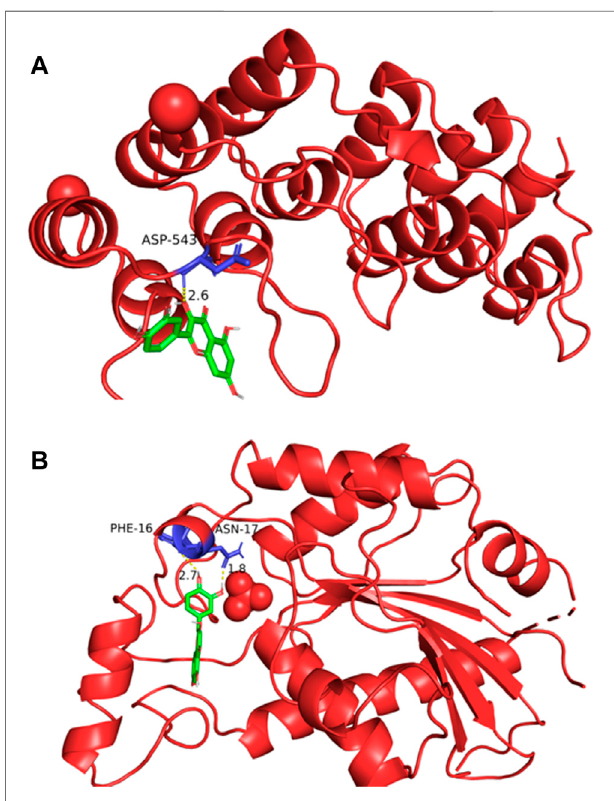
FIGURE 5 | Macromolecular docking pattern diagram. (A) Docking diagram of quercetin and AKT1; (B) docking diagram of quercetin and